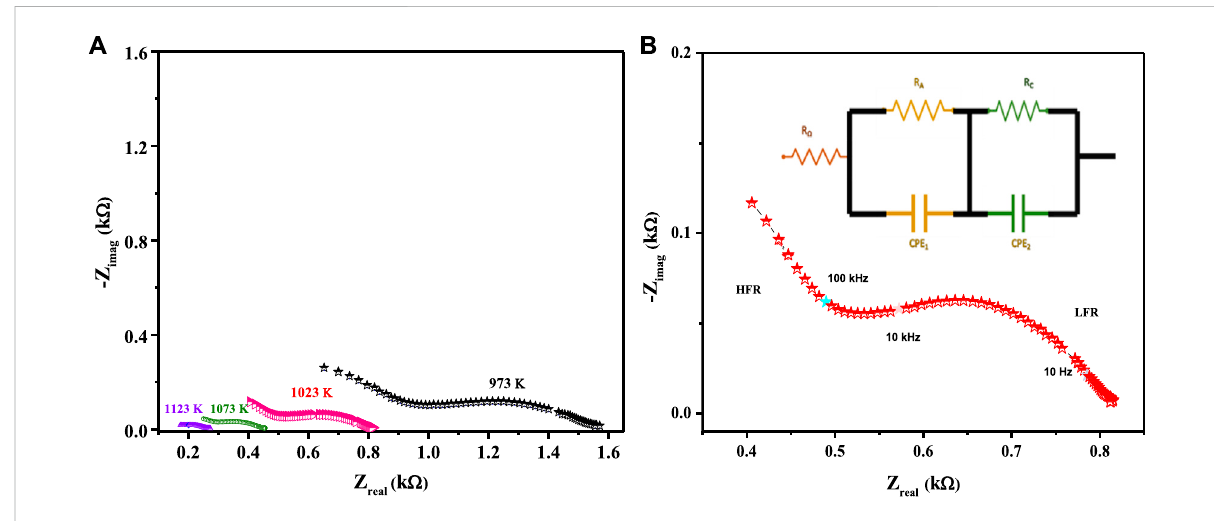
FIGURE 3 HT-EIS spectra ofthree-layered co-pressed asymmetrical cell with 3L-LCNiO-5 inoxygen-methane atmosphereat (A) 973, 1023, 1073, 1123 K and (B) ApotentiostaticorthonormalEISspectrumof3L-LCNiO-5 basedcellrecordedat1023K,EISmodelusedforsimulationofexperimentaldata in the inset.